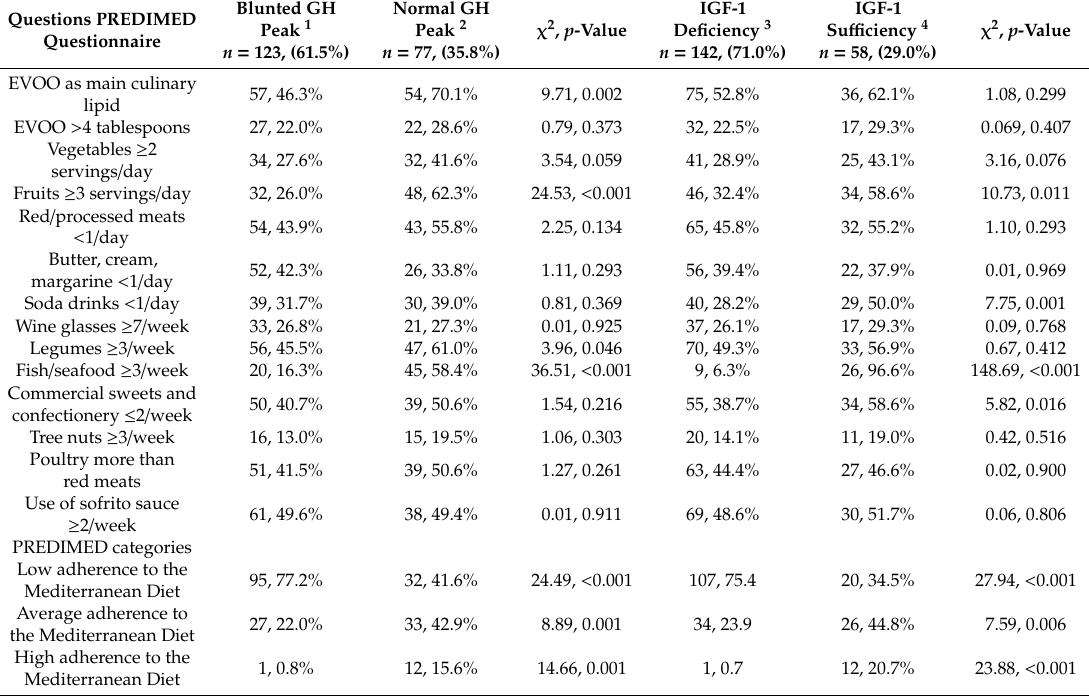
Table 3. Response frequency of dietary components included in the PREDIMED (PREvention with MEDiterranean Diet) questionnaire of 200 adult females with obesity included in the study divided according to blunted GH peak or IGF-1